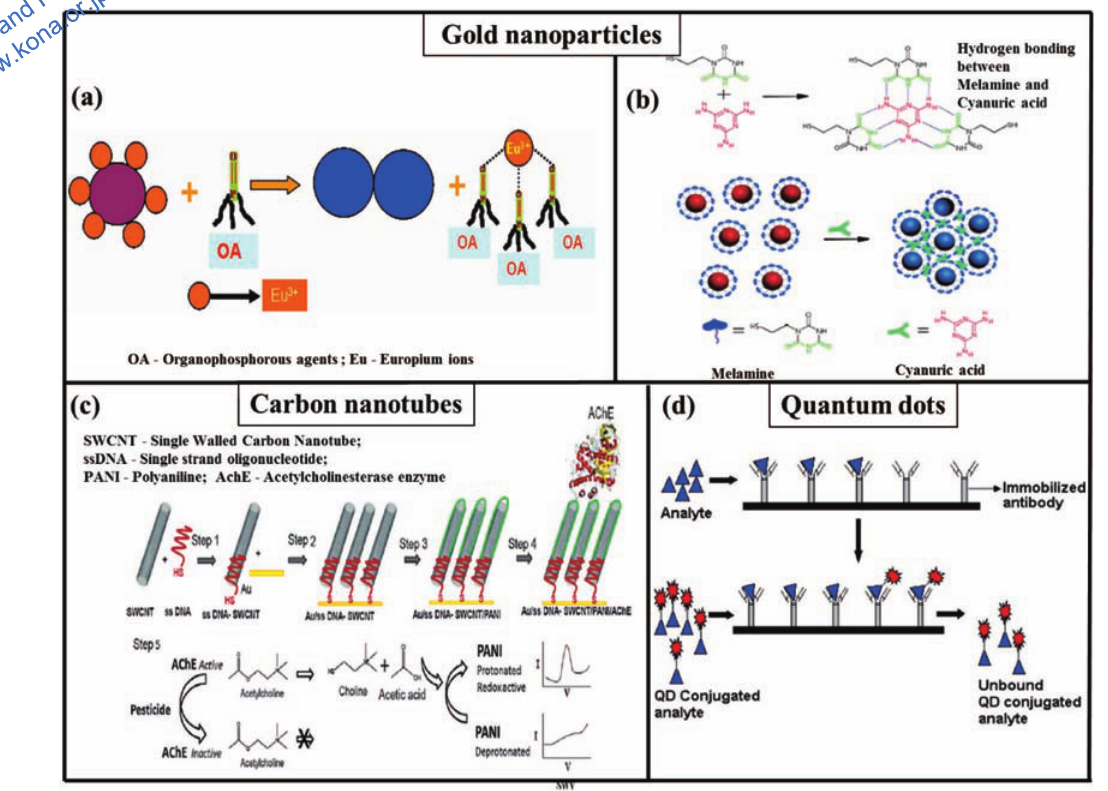
Fig. 2 Schematic of functioning of various biosensors (a) Fluorescence based detection of organophosphorous pesticides using europium tagged gold nanoparticles (Dasary et al., 2008) (b) Colorimetric detection of Melamine in milk using cyanuric acid-gold nanoparticles (Reprinted with permission from (Ai et al., 2009). Copyright (2012) Ameri- can Chemical Society) (c) Electrochemical detection of pesticides using enzyme activated single walled carbon nanotubes (Viswanathan et al., 2009) (d) Color change of the nanoassembly formed by Qdot nanoprobes and target analyte (Reprinted with permission from (Ho et al., 2005). Copyright (2012) American Chemical Society). Table 1 Applications of biosensors in the detection of food-borne pathogens and pesticides